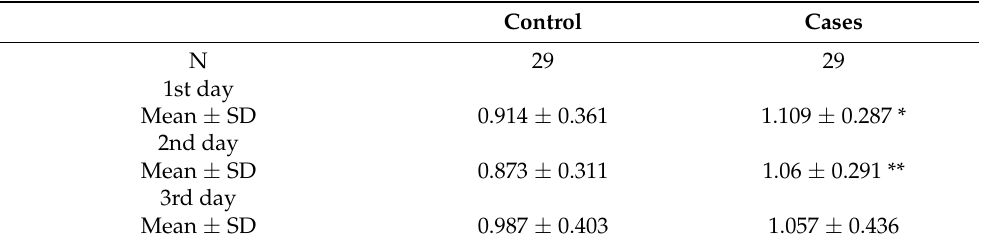
Table 5. Concentrations of Activin-A (ng/mL) in the two studied groups, in the first 3 days of life (Mean ± Standard Deviation (SD)). Control Cases